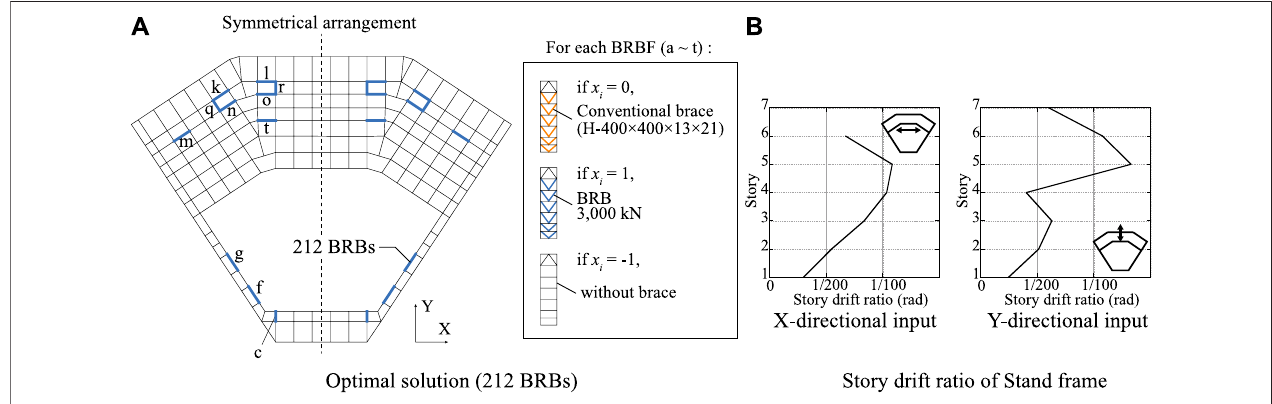
FIGURE 8 | Optimal solution (Layout-C-2): (A) Optimal placement, (B) Maximum story drift ratio.